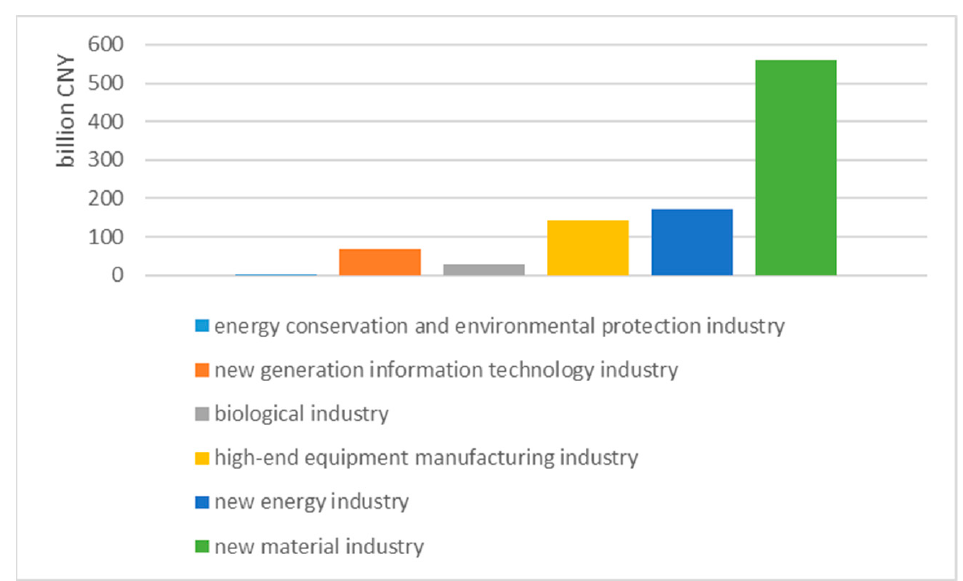
Figure 7. Strategic New Industrial Output Value of the XMA in 2018.